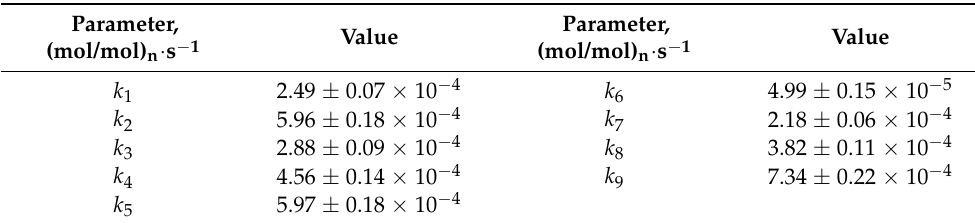
RMS deviation of the experimental data from the calculated data: 4.10 × 10 − 2 .